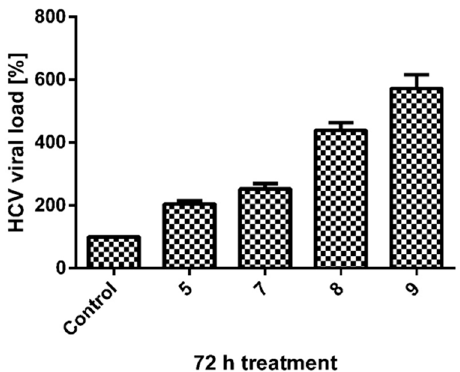
Figure 3. Effect of carbanucleosides 5 (25.00 µM) and 7 – 9 (100.00 µM) on the viral load of HCV in Huh7.5 SG cells.